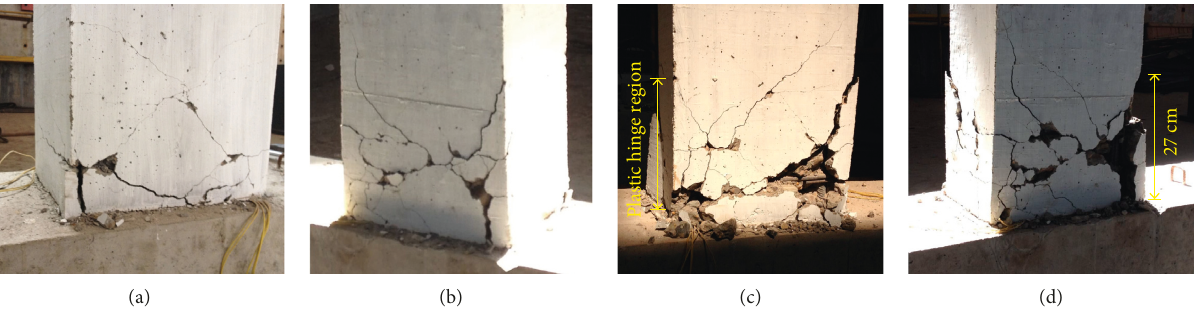
Figure 7: Damage of M-5 at (a) 10th loading cycle; (b) 30th loading cycle; (c) 70th loading cycle; (d) 100th loading